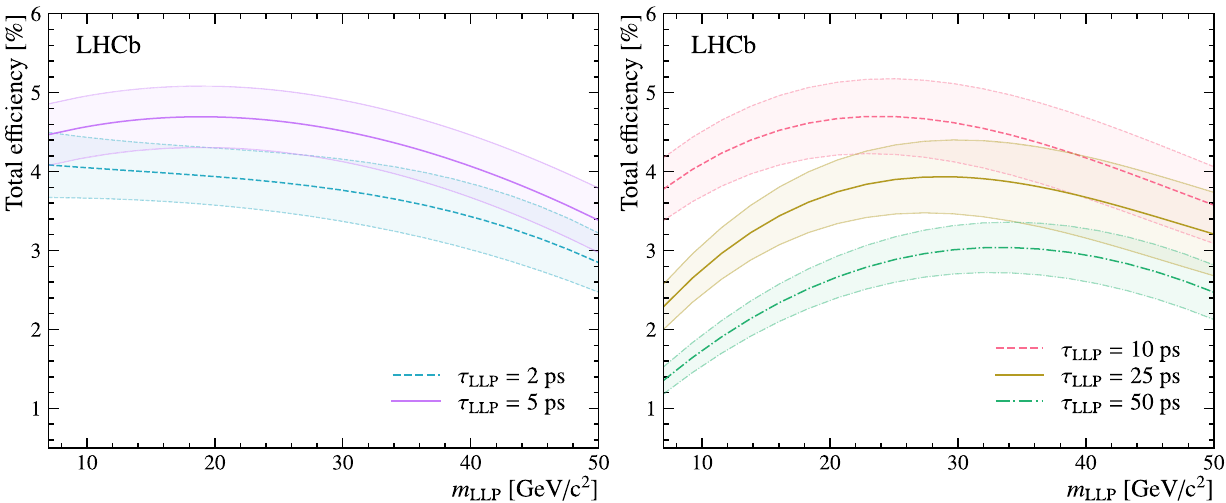
Fig. 5 Total detection efficiency for LLP produced through the DPP mechanism as a function of m LLP (central line) and its uncertainty (coloured band), obtained for different values of τ